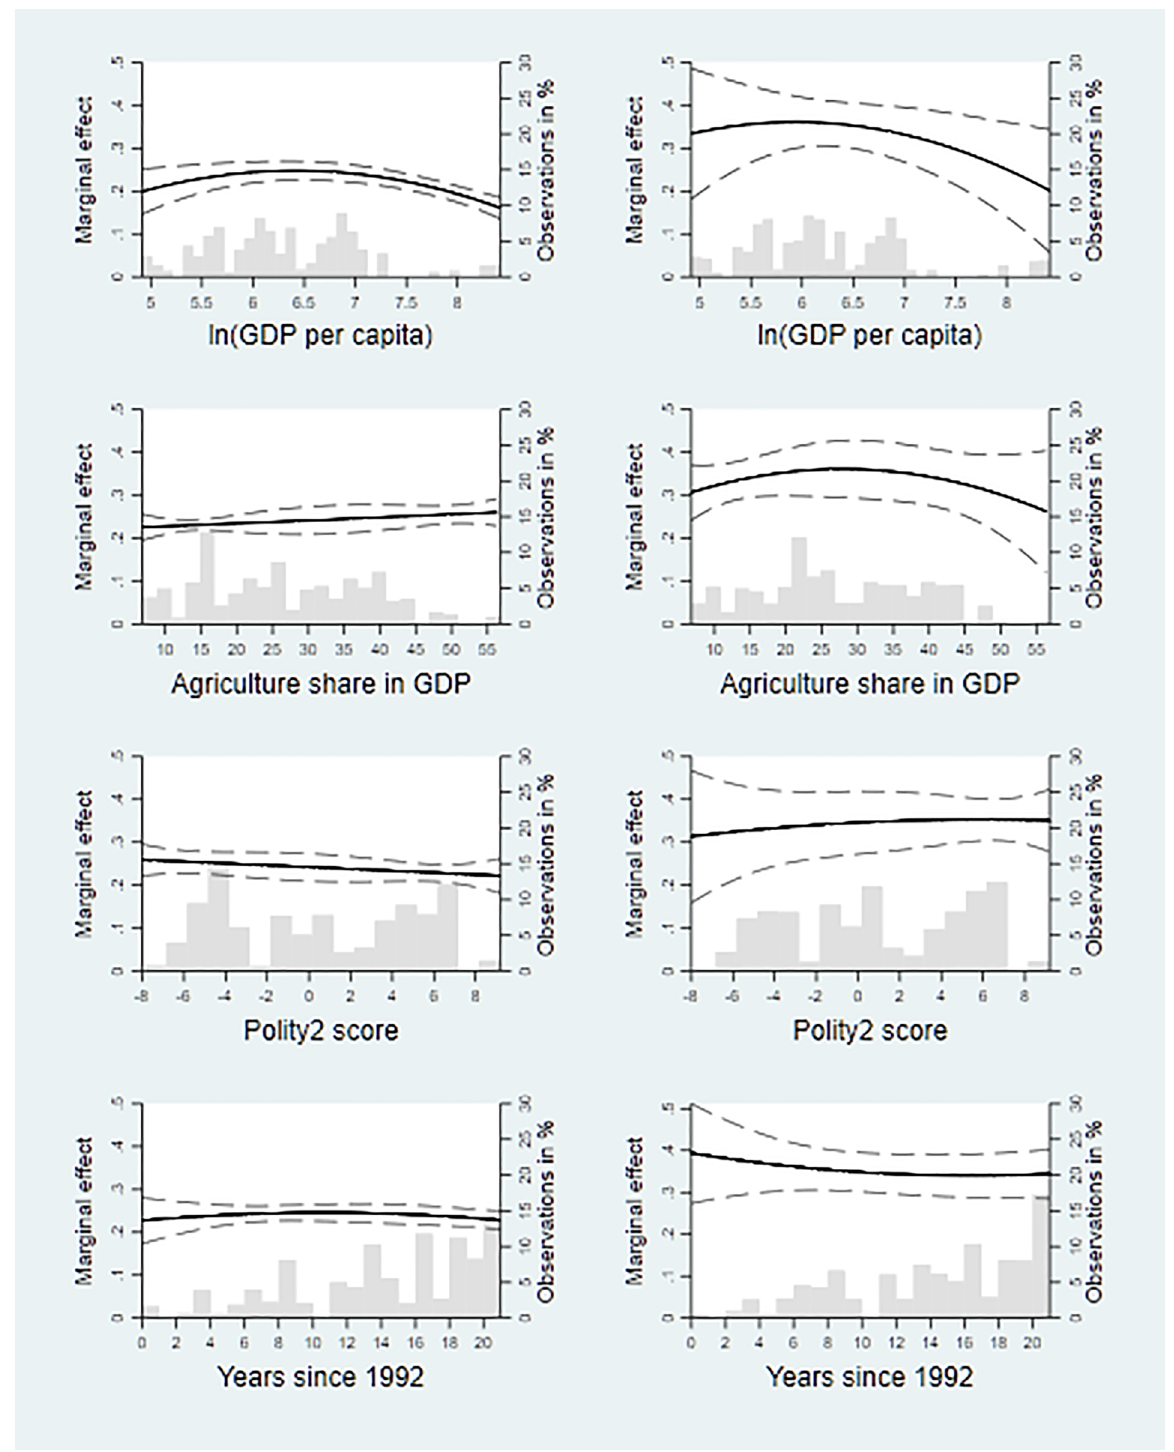
Fig 3. Nighttime lights and household wealth for different country characteristics and over time. Graphs show the marginal effect of ln(light +0.01) on household wealth for different values of four different modifying variables: GDP per capita (in logs), share of agricultural value added in GDP, Polity2 score, and time (measured in years since 1992). Units of observation are circular zones of 2 km (5 km) radius around urban (rural) DHS clusters in the left column and PRIO-GRID cells in the right column. In each graph, the bold curve shows the point estimate of the marginal effect and the dashed curves the corresponding 95% confidence interval (see Eqs 2 and 3). The grey bars indicate the distribution of the modifying variable.